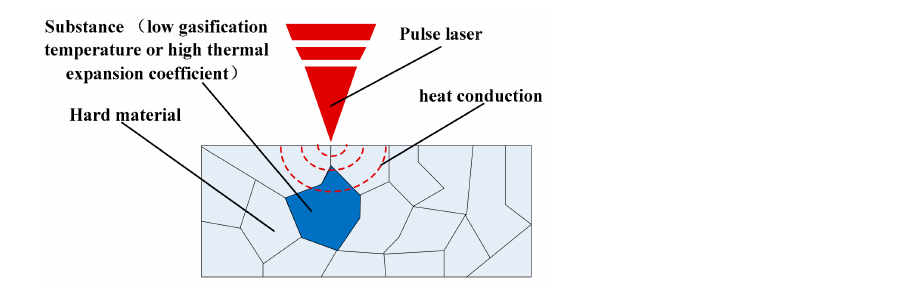
Figure 10. Mechanism diagram of laser cleaning materials with multi-component structures contain- ing substances with low vaporization temperatures or high thermal expansion coefficients